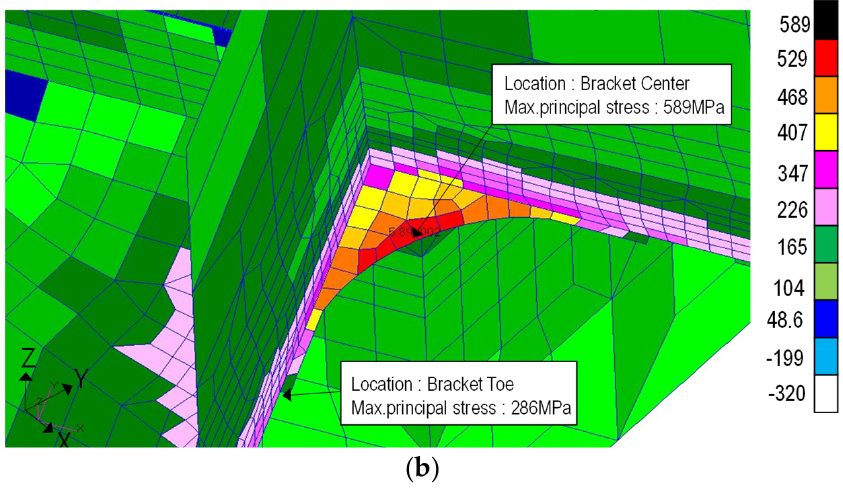
Figure 16. Principal stress result following a change in bracket design. ( a ) Maximum principal stress of the initial bracket model. ( b ) Maximum principal stress of the modified bracket model.